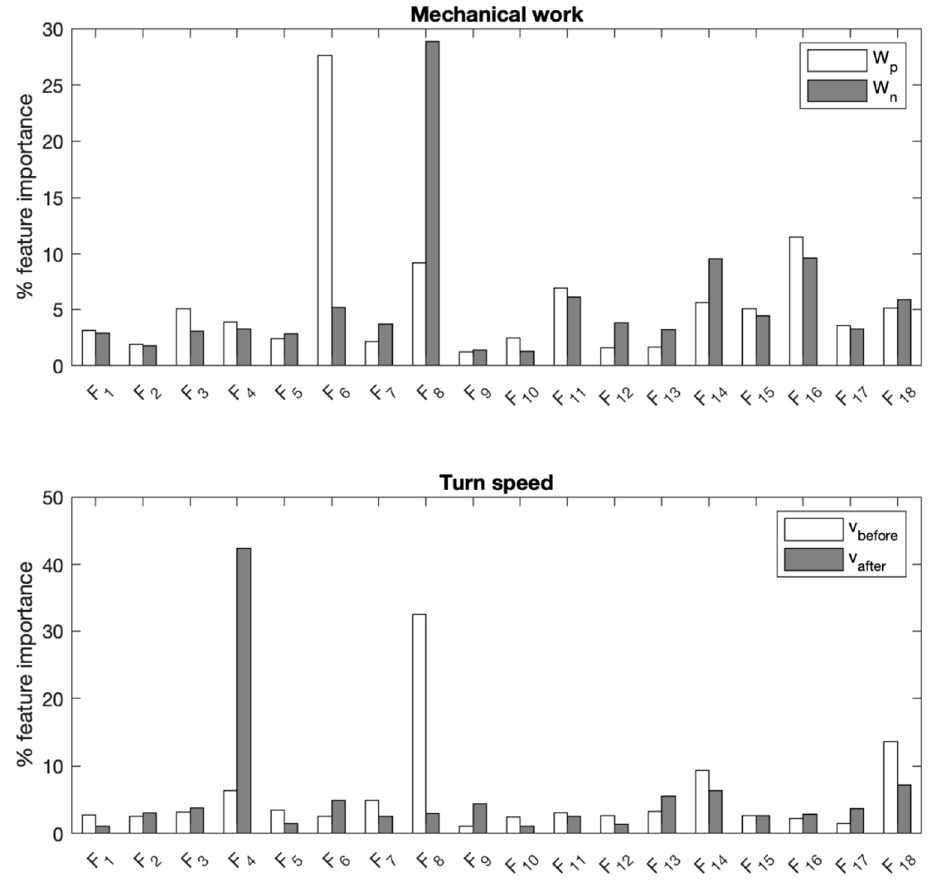
Figure 4. Feature importance returned by boosted trees models when predicting positive/negative mechanical work (W p and W n , top), and approach/sprint running speed (v before and v after , bottom). Refer to Table 1 for the description of features F i .